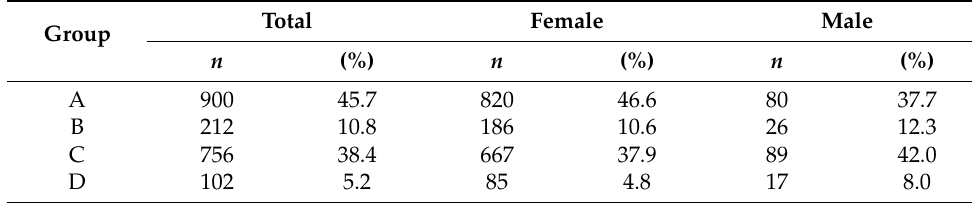
Figure 2. The patient groups of the diagnostic delay for primary Sjogren’s syndrome. Table 1. Number of patients in different groups and